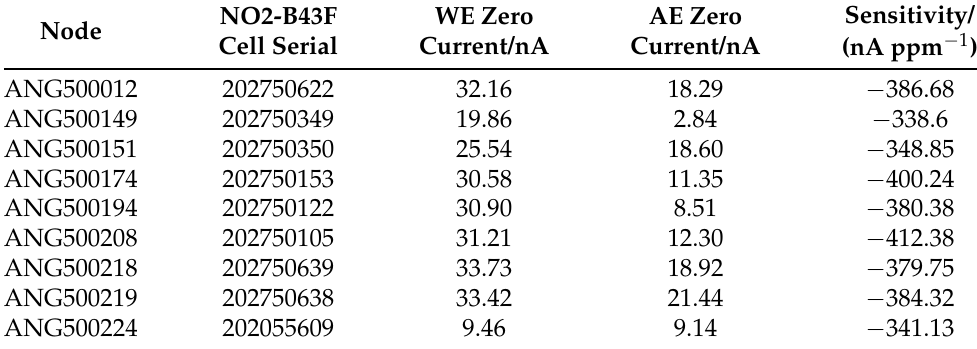
Figure A2. Time-series ( above ) and scatter-plots ( below ) showing the correspondence between the EASE duct and nearby reference station for T ( left ) and RH ( right ) measurements. Table A1. Sensitivity and zero currents for NO2-B43F cells, provided by